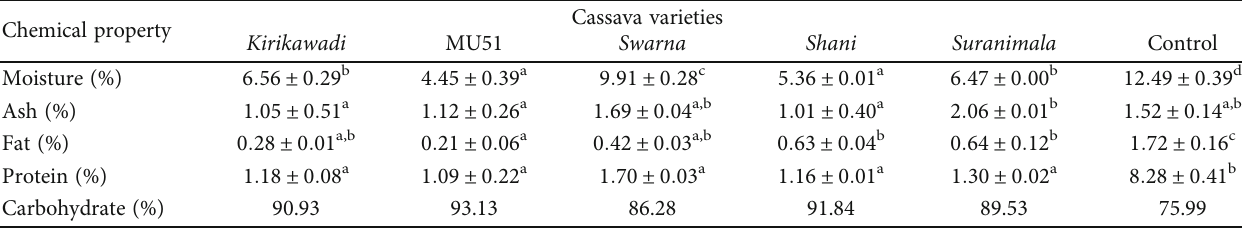
Table 1: Proximate composition of cassava fl ours from fi ve Sri Lankan cassava varieties. Chemical property